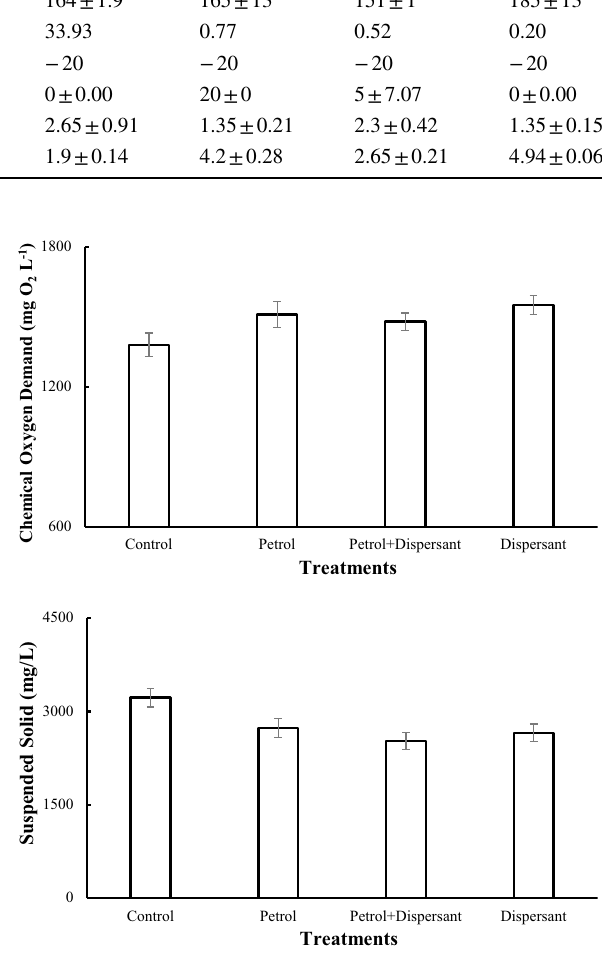
Fig. 2 Variation in COD ( a ) and SS ( b ) values after 40 days of incu- bation. COD is the amount of oxygen expressed in milligrams, con- sumed by existing materials in water and oxidizable under defined operating conditions. SS represent the solid particles responsible for the turbidity of